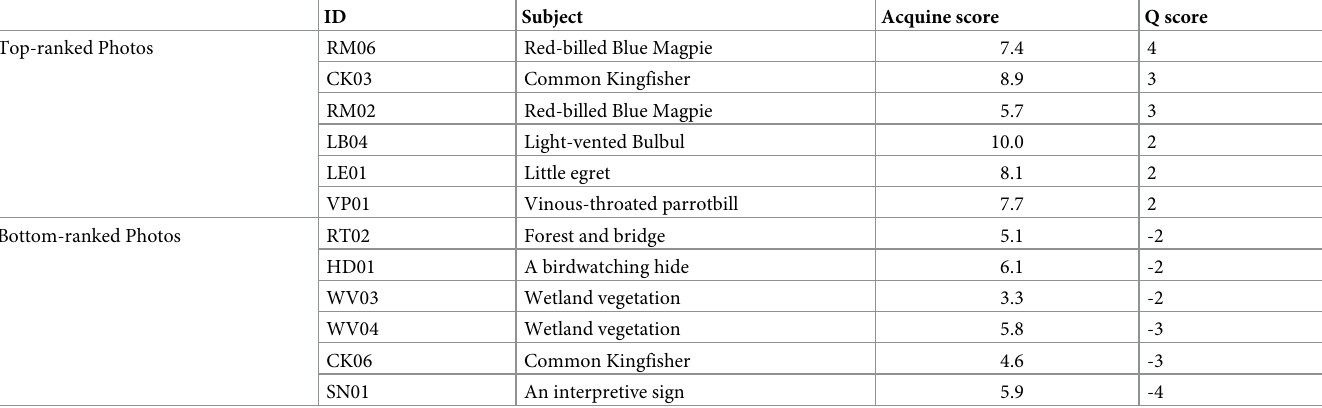
Table 4. The six top-ranked photographs (a) and the six bottom-ranked photographs (b) for Factor